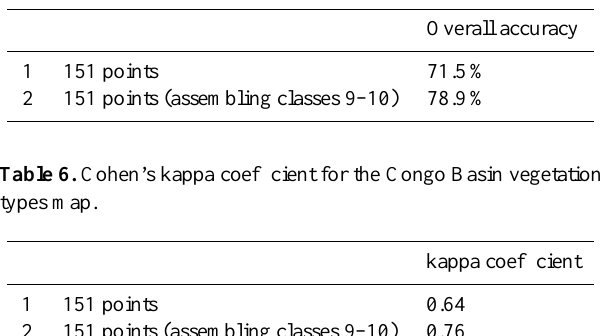
Table 5. Accuracy of the Congo Basin vegetation types map based on surface area figures per class and the user’s accuracy.